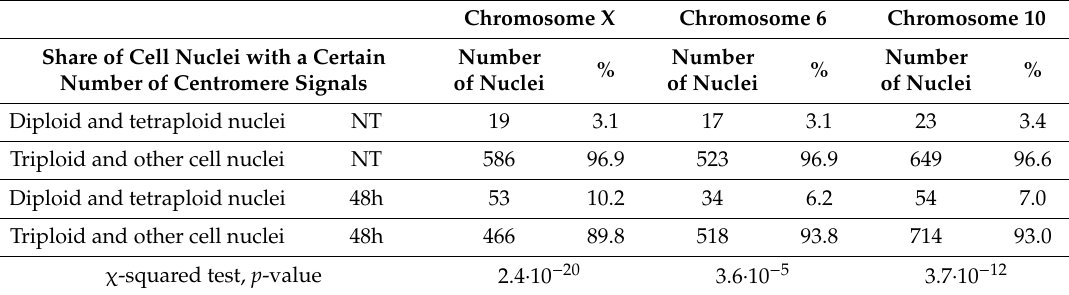
Table 2. Statistically significant and concordant increase of the proportion of diploid and tetraploid cell nuclei tested by FISH centromeres labels of three chromosomes at 48 h post 10 Gy irradiation of HeLa